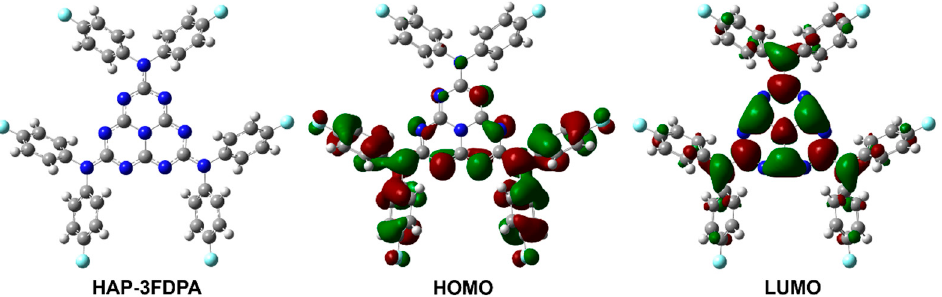
Figure 1. The optimized molecular geometry of the ground state and frontier molecular orbital distributions of HAP-3FDPA by theoretical calculations.